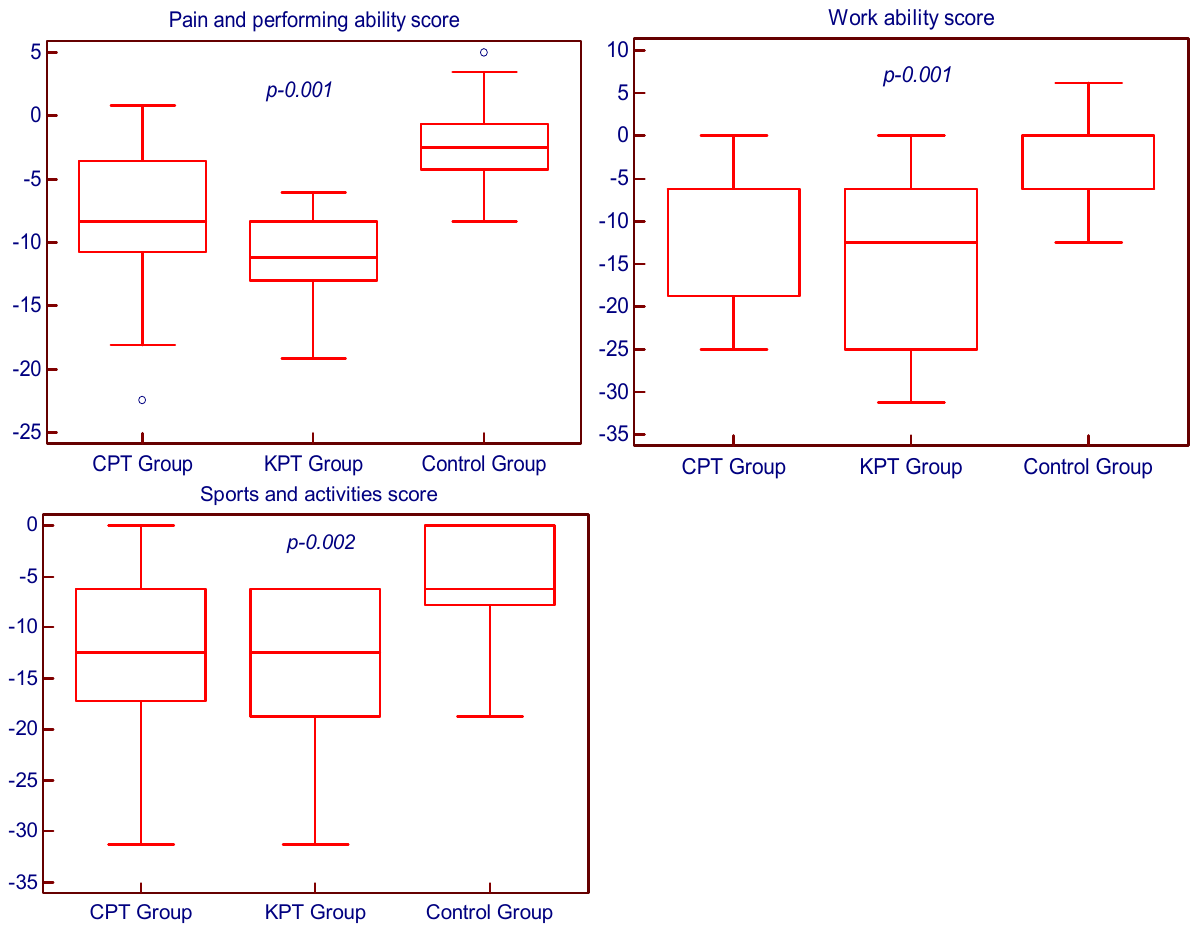
Figure 3. Inter–group comparative analysis of the DASH Outcome Questionnaire score. Figure 2. Inter–group comparative analysis of the shoulder JPS.